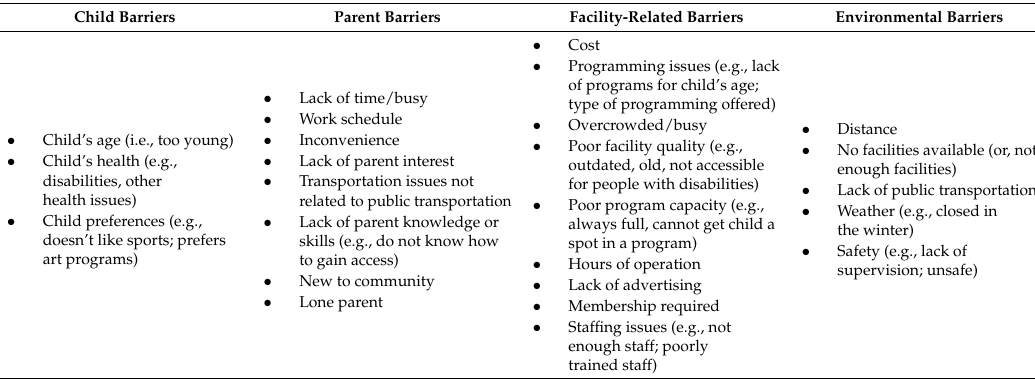
Table 2. Types of barriers to accessing sports and recreation